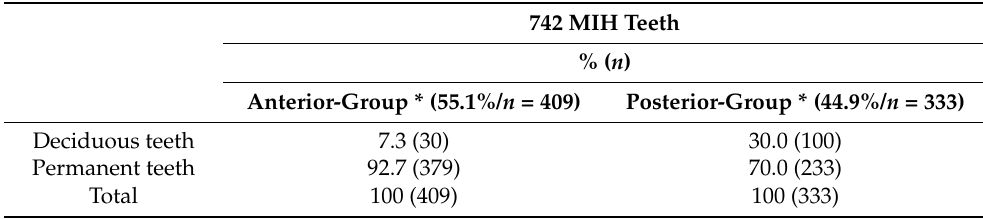
Table A1. Summary of tooth related data on 742 MIH teeth with regard to dentition.